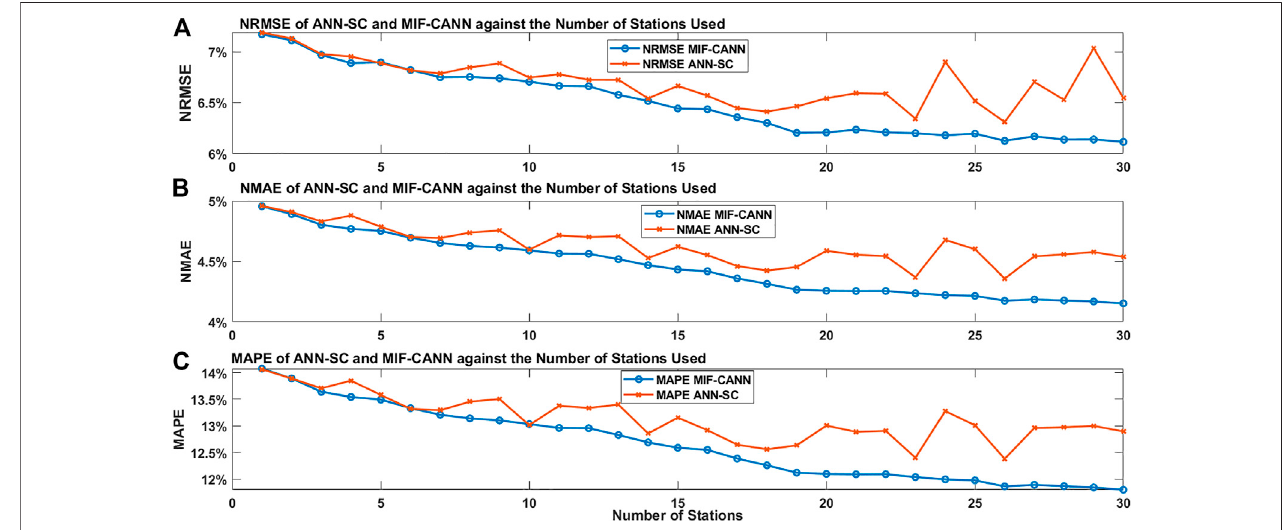
FIGURE 7 | The evaluation results of the ANN-SC and MIF-CANN against input features from different numbers of stations: (A) , NRMSE, (B) , NMAE, (C) , MAPE.